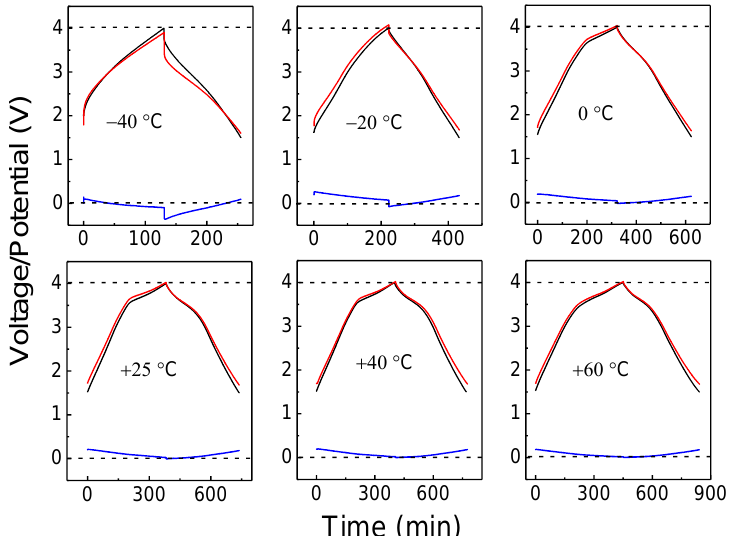
Figure 15. Temperature performance of NCM-based LIBC [95].